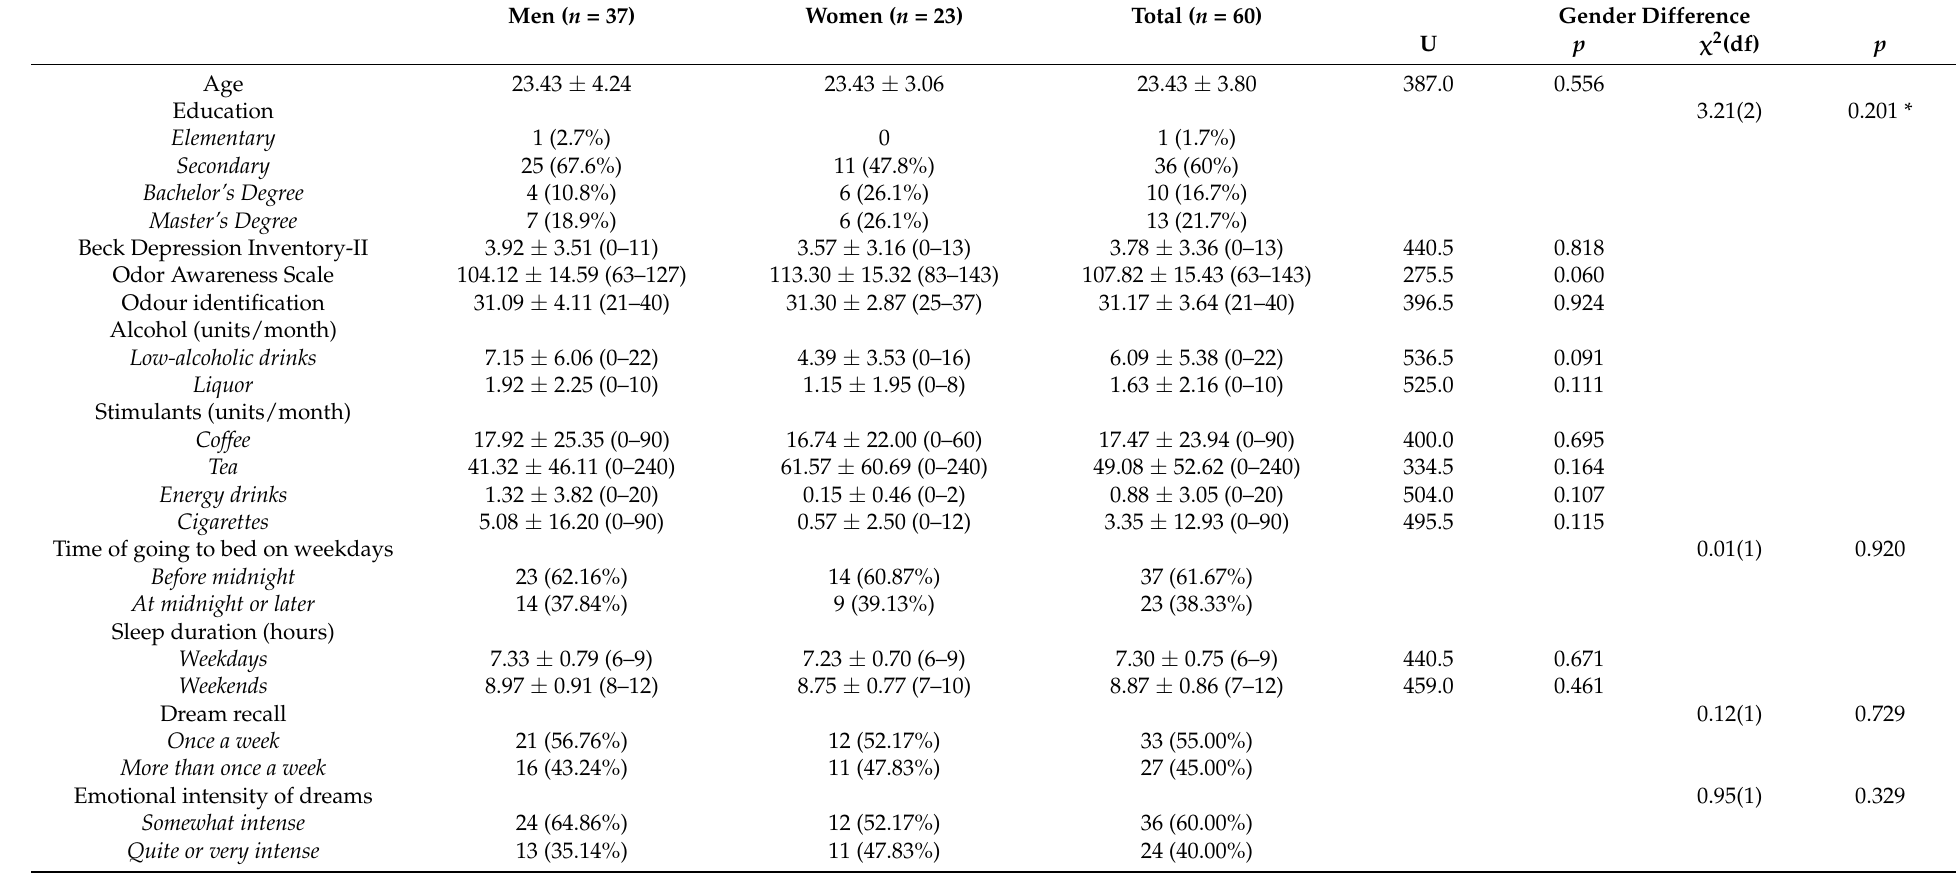
Table 1. Absolute and relative frequencies for education, time of going to bed, dream recall, and emotional intensity of dreams; and mean ± SD (range) for age, Beck Depression Inventory-II, Odor Awareness Scale, and University of Pennsylvania Smell Identification Test (‘odour identification’) scores, consumption of alcohol and stimulants, and usual sleep duration. Alcohol units for soft alcohol represent a small beer (0.33 L) or a glass of wine (0.2 L); for hard alcohol a 0.02 L glass. Units for coffee/tea and energy drinks are cups and cans, respectively. Gender differences were explored with Mann-Whitney U and Pearson chi-square tests. An asterisk (*) denotes a comparison for which the Freeman-Halton extension of the Fisher exact probability test for a two-rows by three-columns contingency table was